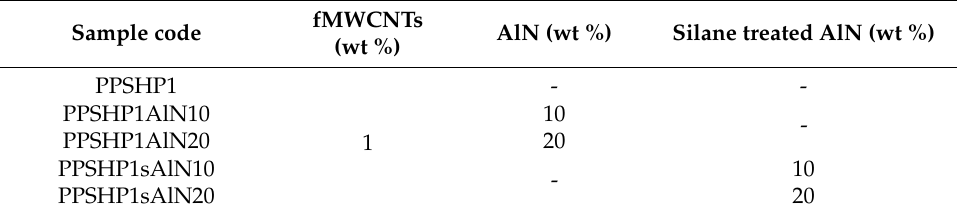
Table 1. The compositions of the PPS/MWCNTs/AlN